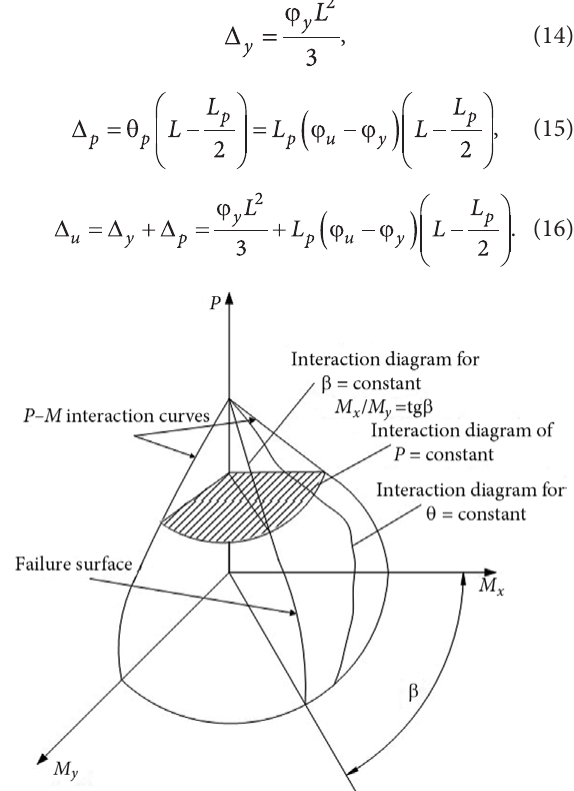
Fig. 3. Three-dimensional P–M the interaction yield surface